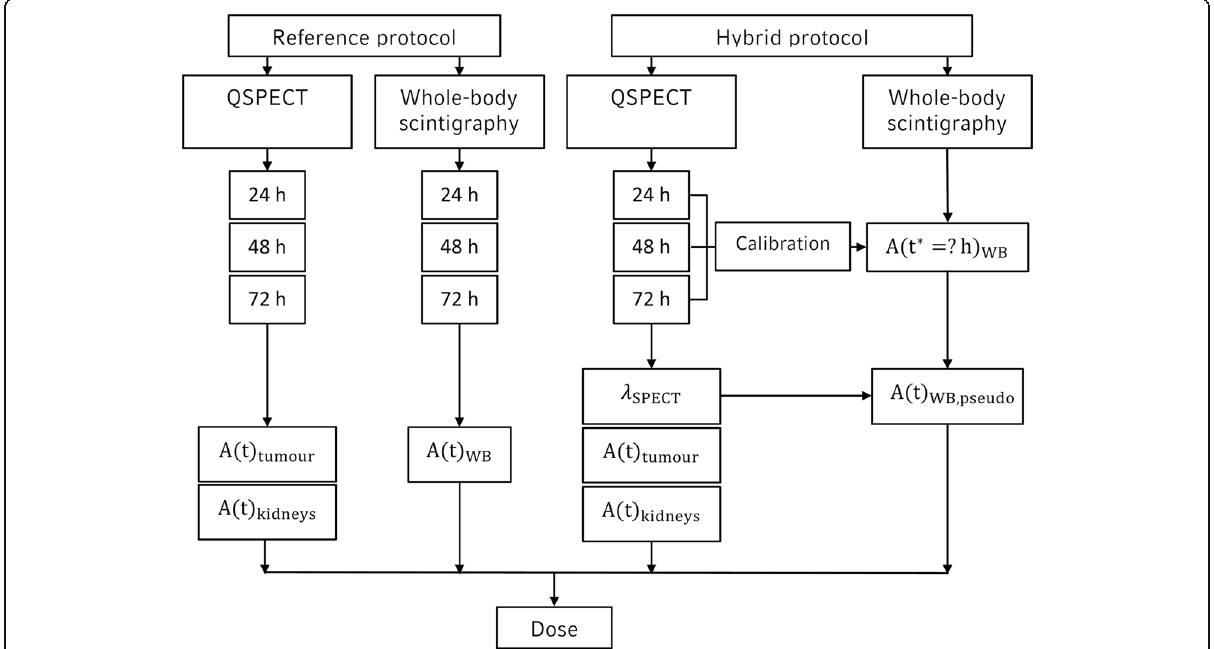
Fig. 2 Illustration of the reference protocol (RP) and the proposed hybrid protocol (HP); for the hybrid protocol, the sequential whole-body planar imaging is replaced by a single whole-body planar acquisition at an appropriate time point at 24, 48, or 72 h p. i. (HP24, HP48, HP72); QSPECT indicates quantitative